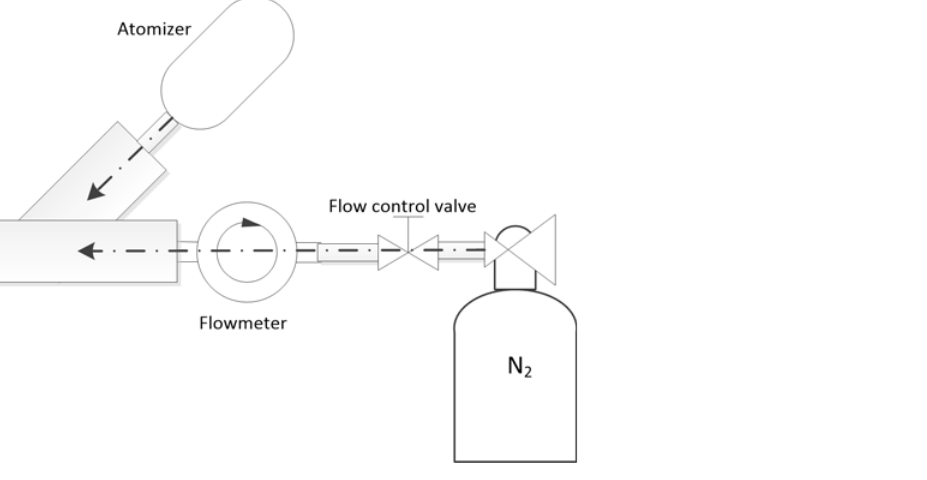
Fig 1. Schematic diagram of experiment setup used in this